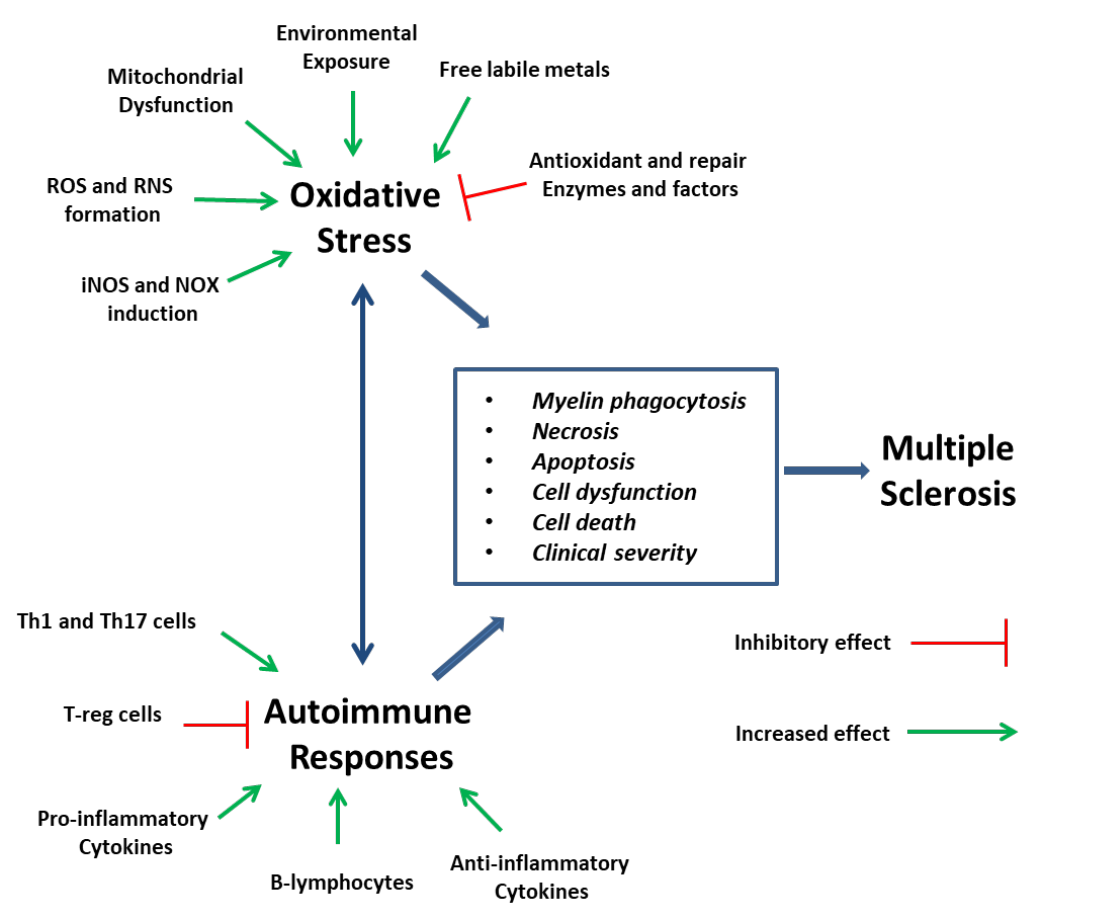
Figure 11. Potential levels of implication of natural antioxidants in the MS initiation and progres- sion.